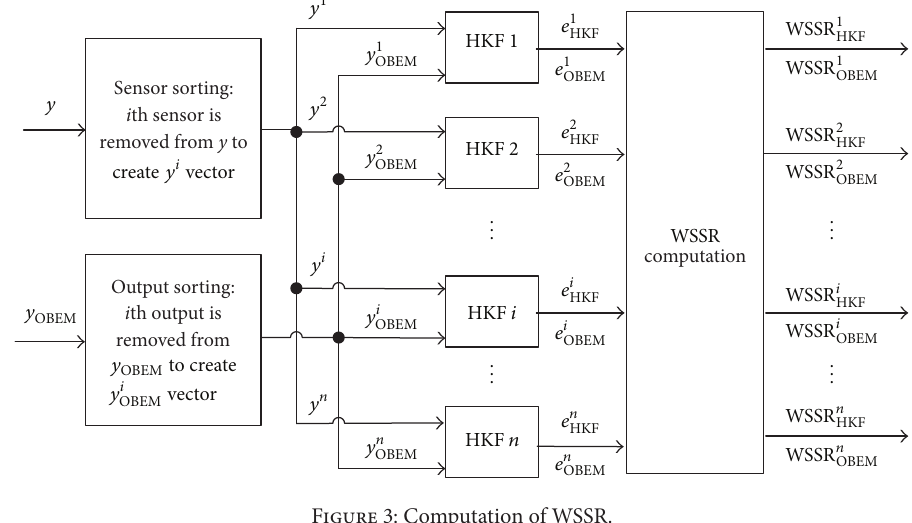
Figure 3: Computation of WSSR.